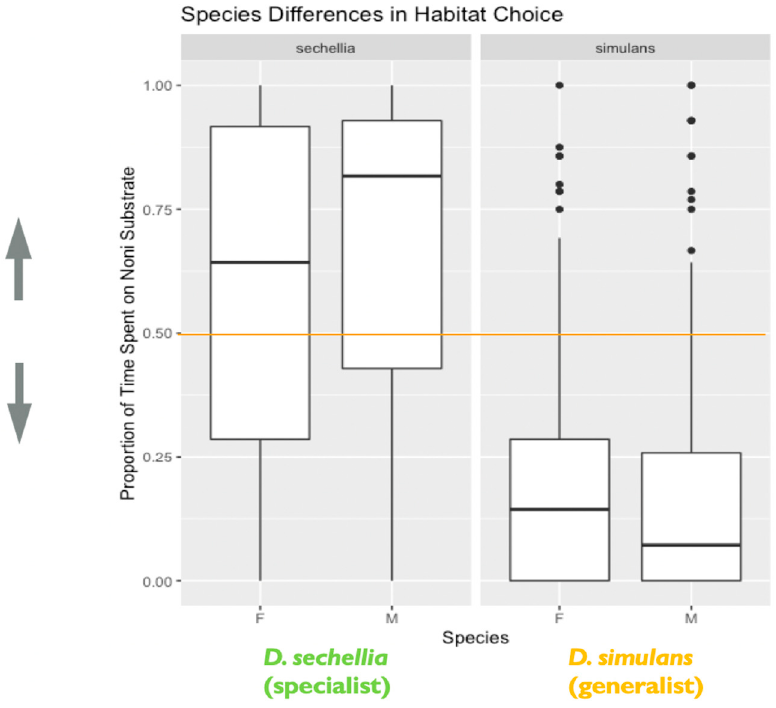
Figure 4. Species and sex di ff erences in habitat choice: the plot represents species and sex di ff erences in habitat (food substrate) choice, as noted in the main text. Data are from the second experiment measuring habitat choice as a representation of decision making. The y-axis represents the proportion of time spent on the imitation noni substrate. Lower values closer to 0 indicate a habitat preference for the plain substrate, while higher values closer to 1 indicate a habitat preference for the imitation noni substrate. A value on or near 0.5 (marked by the orange line) indicates no demonstrable habitat preference for either the plain or imitation noni substrates ( n = 526 flies). The box in the plot represents the inter-quartile range of scores, including the middle 50% of scores for the group, with the median score represented by the middle quartile mark (or line). The whiskers represent the score ranges outside the inter-quartile range, including the top 25% of scores for the group in the upper whisker, and the bottom 25% of scores in the lower whisker. The dots beyond the whiskers represent outlier values. Our findings indicated that species di ff ered significantly in habitat choice. Additionally, sex significantly influenced habitat choice, with males showing stronger habitat choice preference than females.